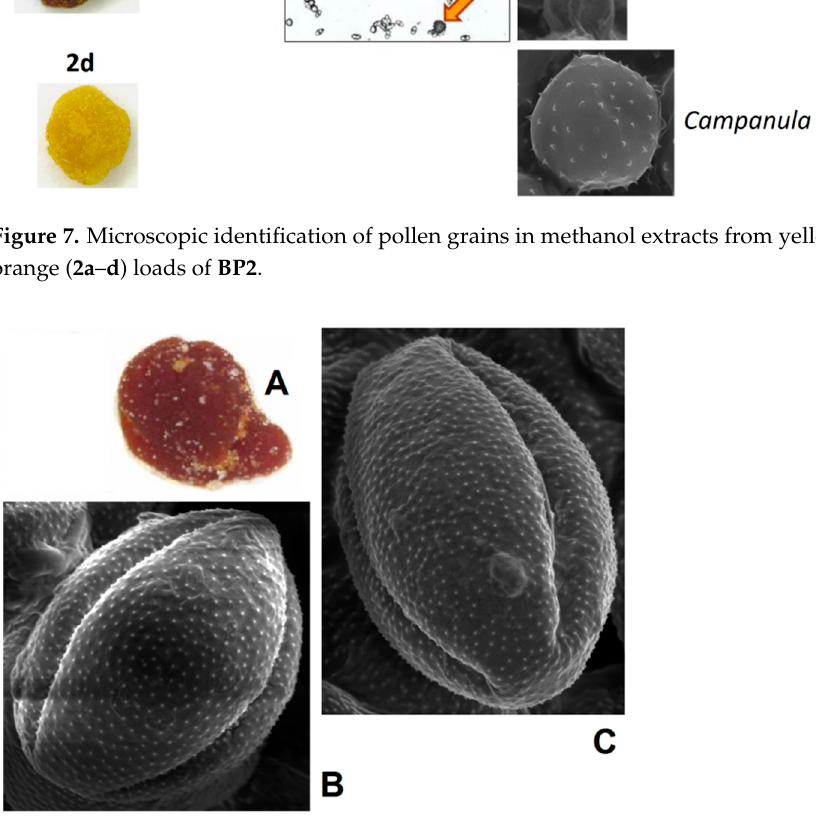
Figure 8. SEM images of pollen grains in brown loads ( A ) found in BP7 ( B ) and BP3 ( C ).